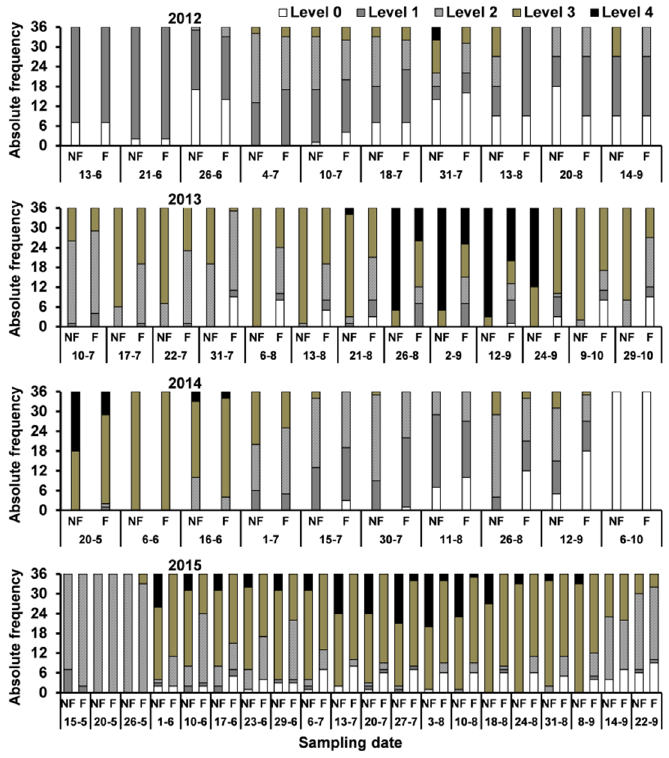
Figure 1. Absolute frequency of infestation levels of A. nerii on oleanders surrounded with (F) and without (NF) service plants in the study period (2012–2015). Levels correspond to the scale of infestation severity of aphids in oleanders cited in Table 1 [26,27]. Table 2. Chi-squared test and p -values for comparing absolute frequencies of infestation levels in plots surrounded with (F) and without (NF) service plants (sweet alyssum, marigold, large-flowered tickseed, and yarrow) in each of the study years (2012–2015).